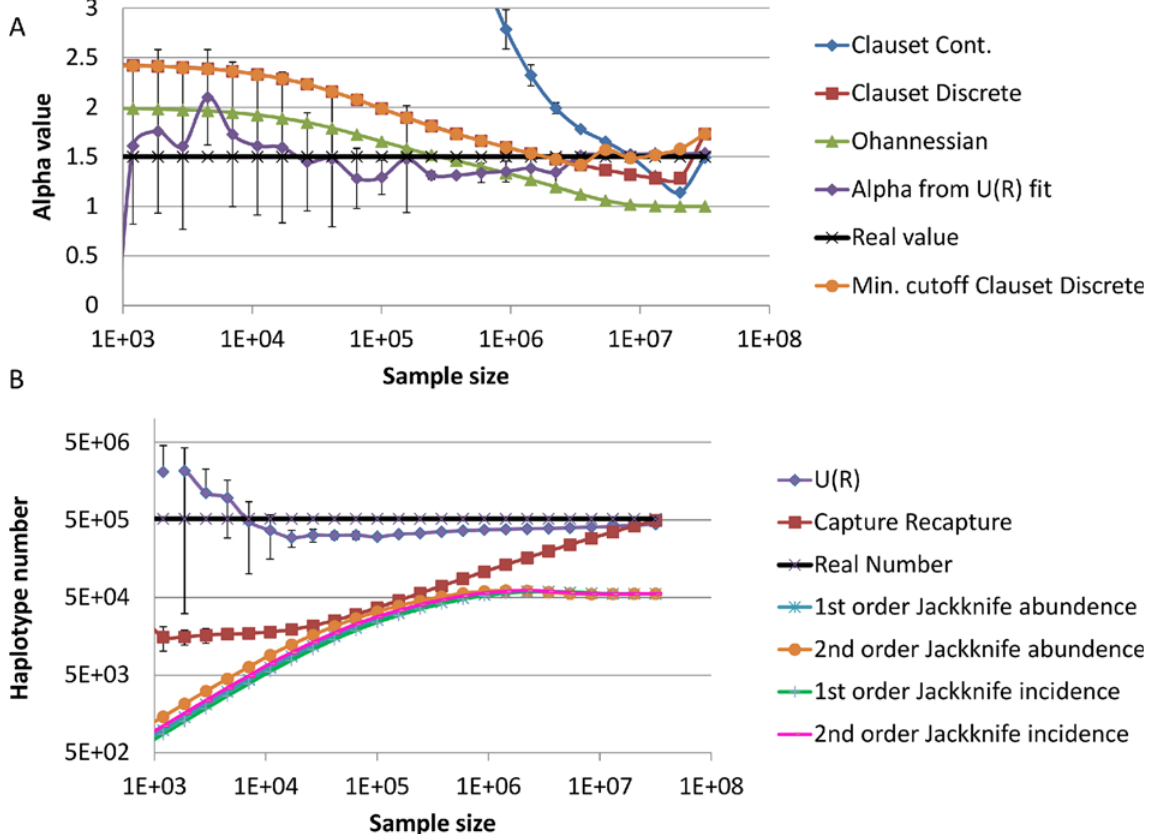
Fig 1. Estimation of α and of haplotype number for different sample sizes. A. Convergence of estimates of the power of distribution α to real value in samples from a simulated scale free distribution with a lower cutoff. The real value is the black line with the 'x' signs. The estimate using our method quickly converges to the proper value — 1.5 (purple line with diamonds). The estimates using either the discrete (red line with squares) or continuous (blue lines with circles) Clauset estimates, or the Ohannessian et al. estimate (green lines with circles) do not converge, even when more than half the distribution is sampled. A Clauset discrete estimate with a minimal cutoff (orange line with circles) converges almost as well as our algorithm. B. Comparison of haplotype number estimate as a function of the sample size, using a capture recapture method (red squares), Jackknife estimators and the parametric estimate proposed here (blue diamonds), using the same simulation as above. The real number is a black full line with 'x' signs. One can clearly see that the parametric estimate developed here converges to a good estimate, even for a very small sample.